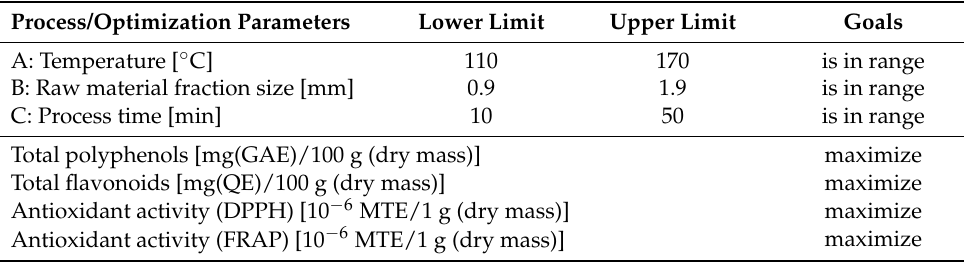
Table 2. Optimization goals and